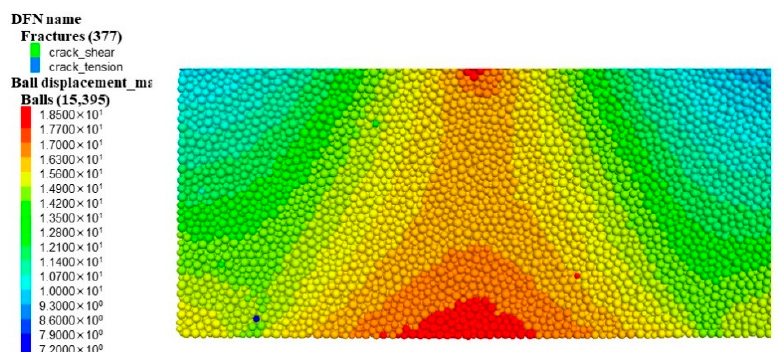
Figure 12. Numerical simulation of stress test. The curve of the fire resistance test and pressure test parameters for the panel is shown in Figures 13 and 14. Each step in the diagram represents a unit of time .